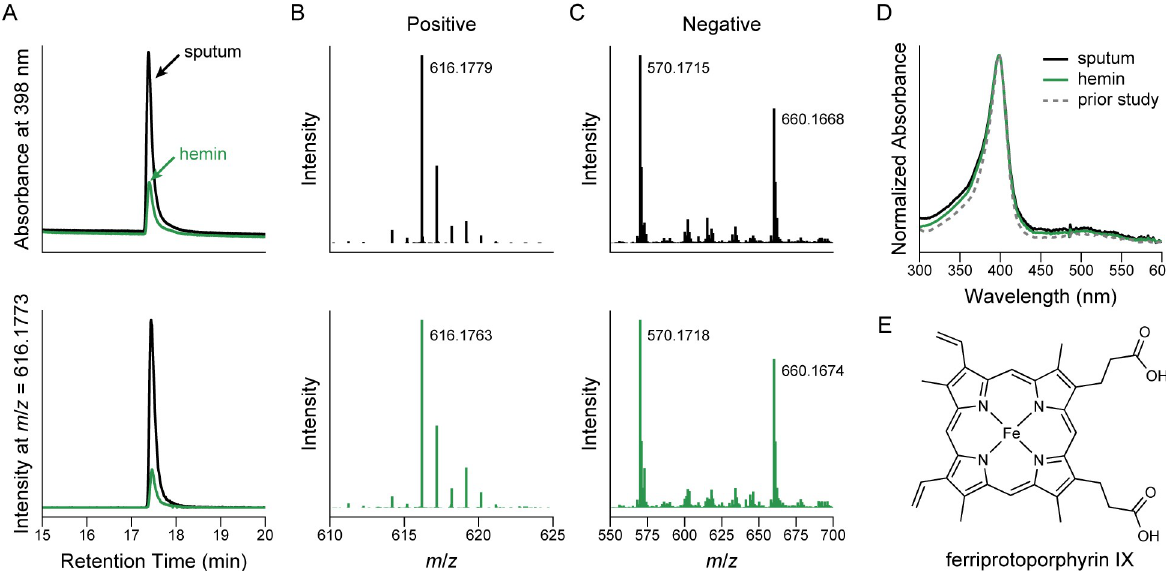
Fig 1. Identification of heme in sputum samples by comparing sputum (black) to a hemin standard (green). (A) UV–vis chromatogram (top) and extracted ion chromatogram (616.1773 ± 0.01 Da) from the positive mass channel (bottom) demonstrating identical retention times. (B) The associated positive ions detected from the peak shown in A, comparing the sputum peak (top) to the hemin standard (bottom). (C) The associated negative ions detected from the peak shown in B, comparing the sputum peak (top) to the hemin standard (bottom). A collision-energy ramp of 10 to 14 eV was applied to generate a fragmentation pattern. (D) Comparison of the UV–vis spectra for the peaks in A (black and green) compared to the same peak identified in our prior study (gray, dashed). For clarity, the spectra are normalized to their maximum value. (E) The chemical structure assigned to the peak in A, ferriprotoporphyrin